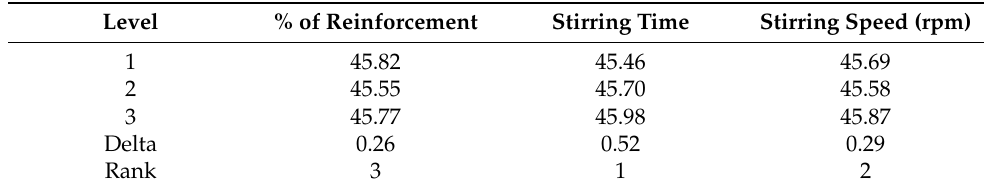
Table 8. Response table for signal to noise ratios (ultimate tensile strength).